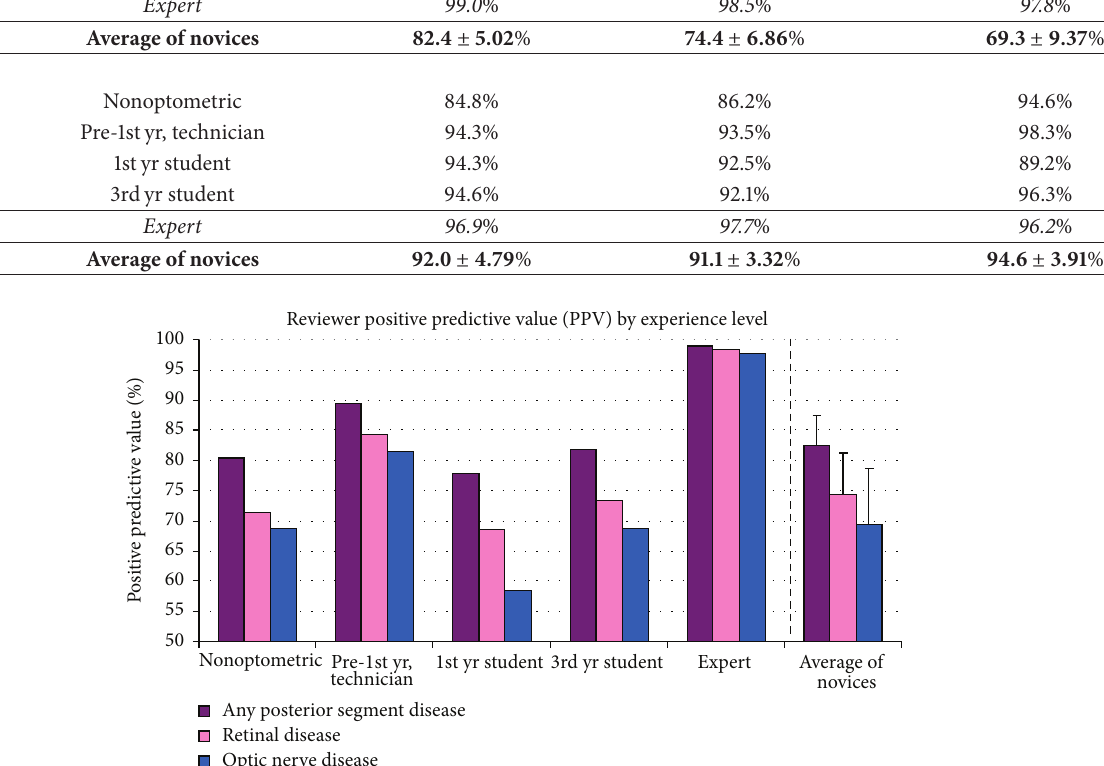
Figure 3: Reviewers’ positive predictive value (PPV), based on data provided with iWellnessExam™. On average, novice reviewers were able to correctly predict whether a subject had disease 82 ± 5 % of the time. There was a greater tendency for the novices to overrefer for optic nerve disease than for retinal disease, in all cases.